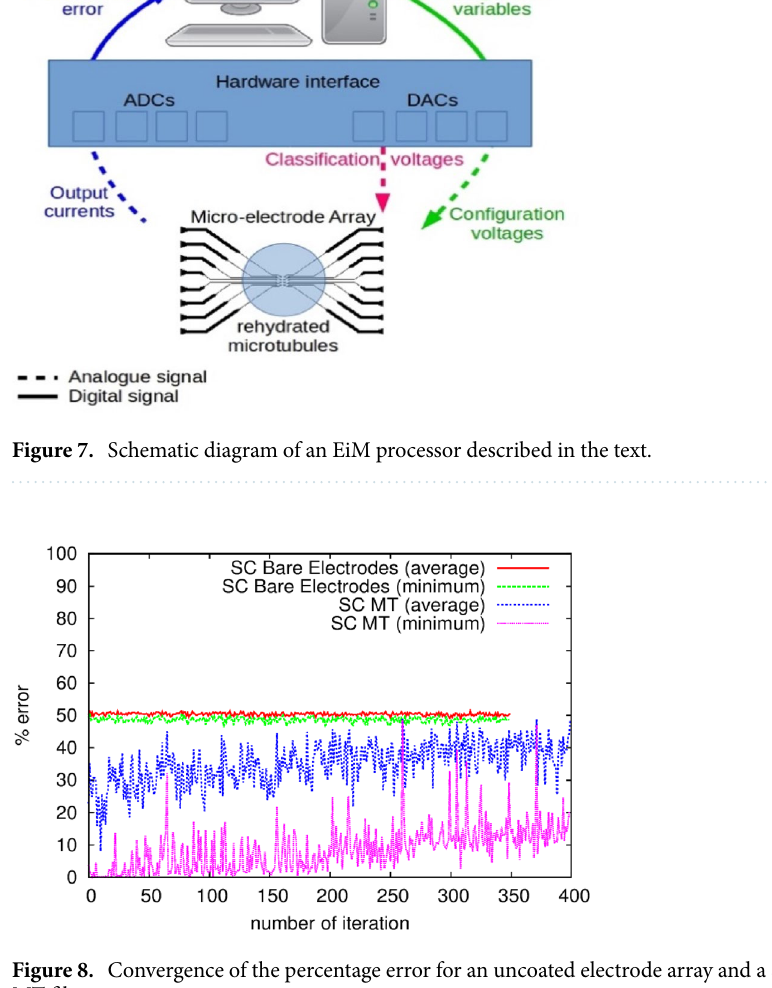
Figure 8. Convergence of the percentage error for an uncoated electrode array and a sealed, rehydrated 12 µl MT